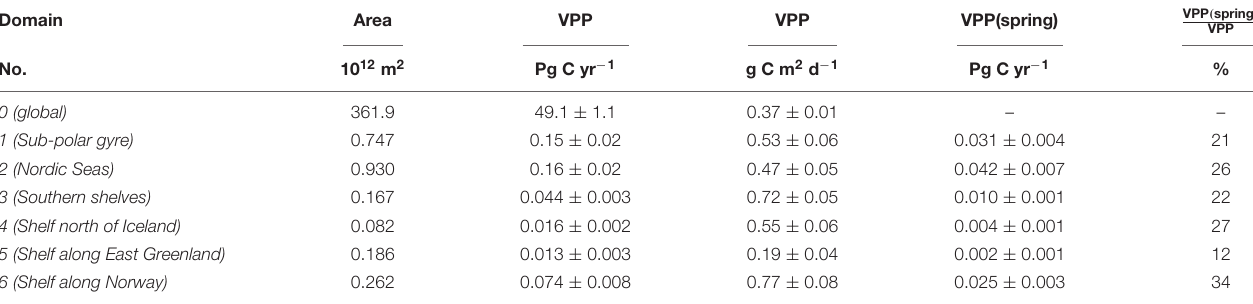
TABLE 1 | Annual average PP calculated by the VPP-model, for the period 2003–2013, for the global domain (domain no. 0) and for the six subdomains in the northern North Atlantic (domain 1–6). Domain Area